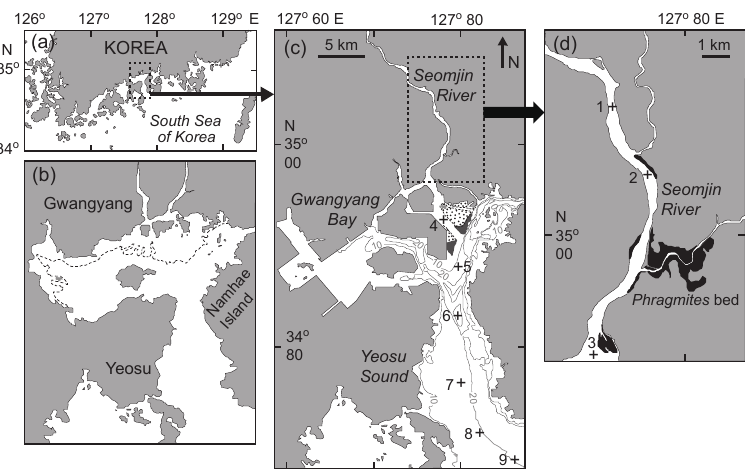
Figure 1. Map showing the location of Gwangyang Bay (a) , the appearance of the bay before the reclamation of tidal flats in 1982 (b) , and the sampling stations in the bay (c) and in the estuarine channel (d) . The broken line represents the lowest water line (b) ; the dotted areas show intertidal beds and the dark gray areas Zostera beds (c) ; and the darker areas show Phragmites beds (d)